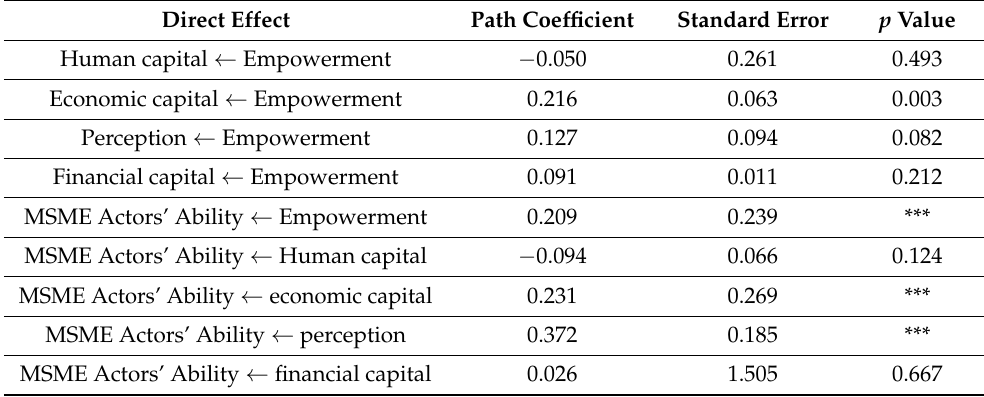
Table 9. Direct effect path analysis test results.